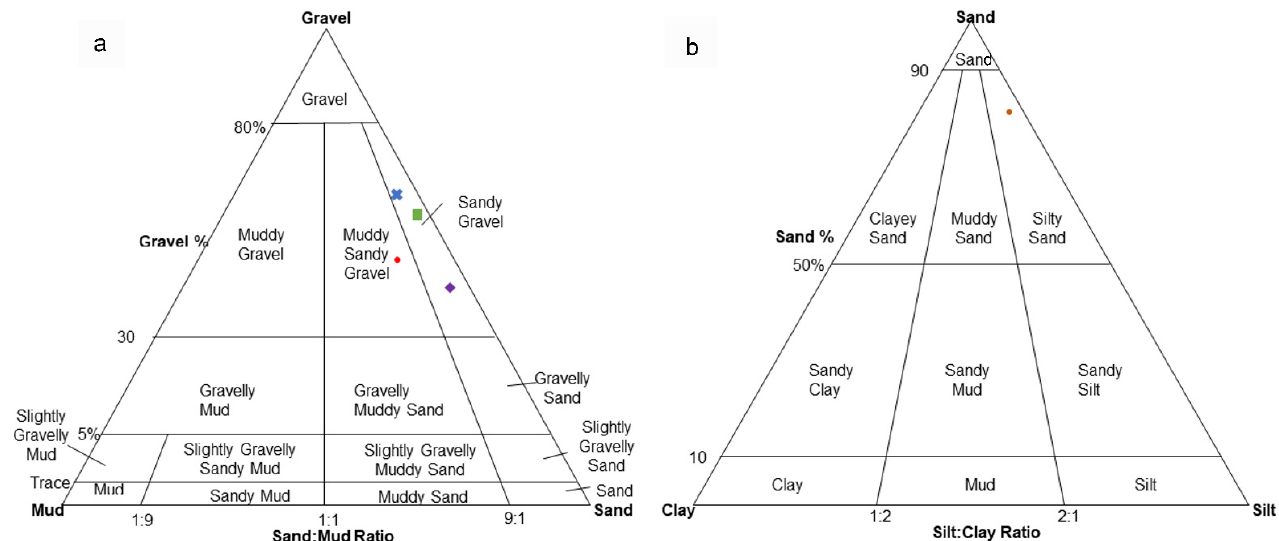
Figure 2. Granulometric composition of the samples: ( a ) shows gravel–mud–sand diagram in which are samples of the Mala Martinska Cove, MMART0-3 (×) and MMART5 ( ♦ ), Mala Stupica Cove, MSTUP0-3 ( ■ ) and tailings samples (•). In the sand–clay–silt diagram ( b ), only dust sample is shown (•).